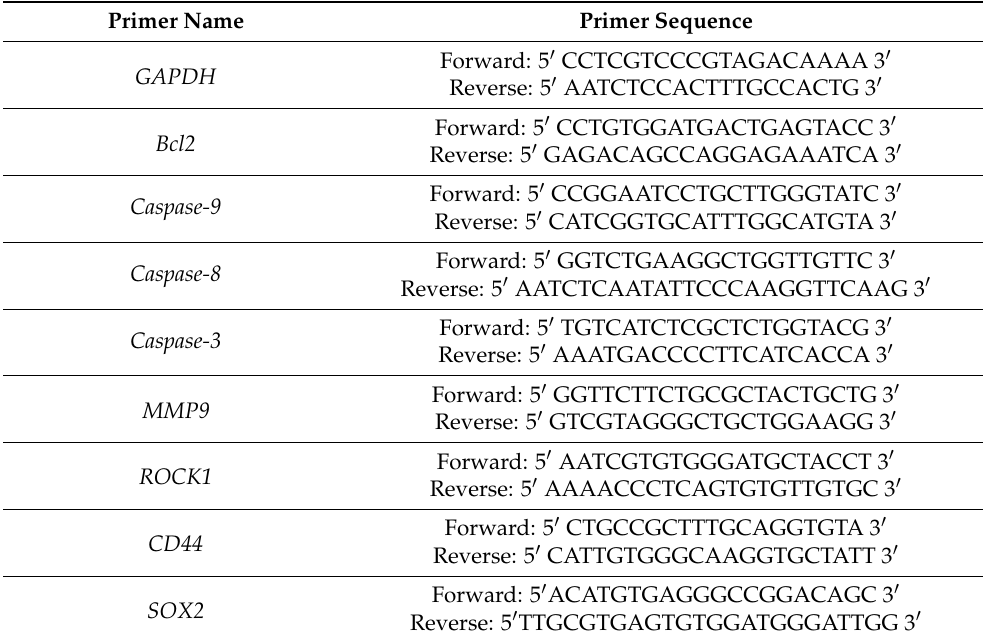
Table 3. Primers